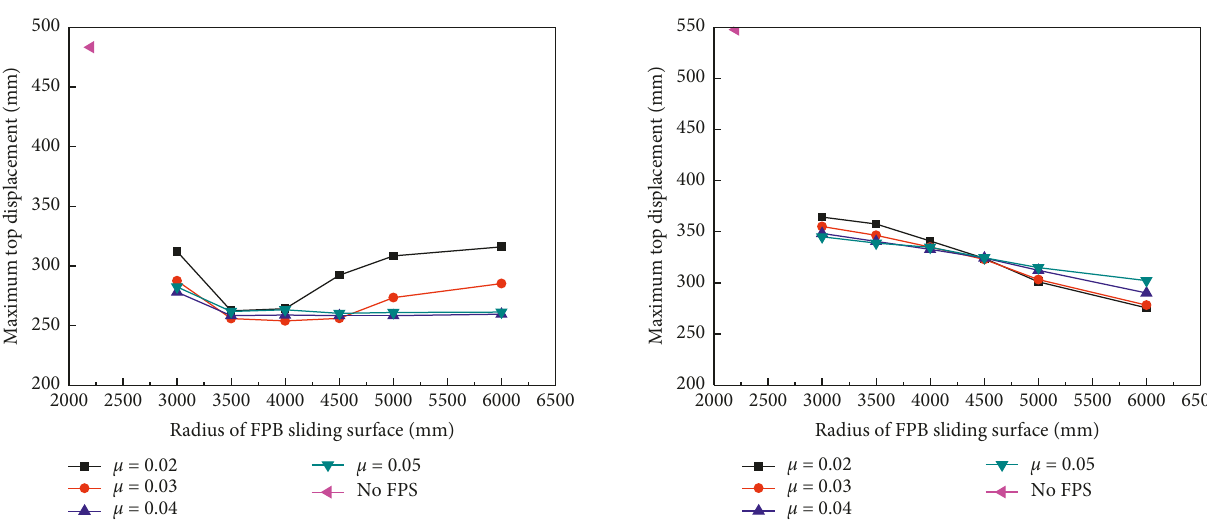
Figure 22: The maximum top displacement of T4S tower with R and μ in the Y direction under L0689S wave.